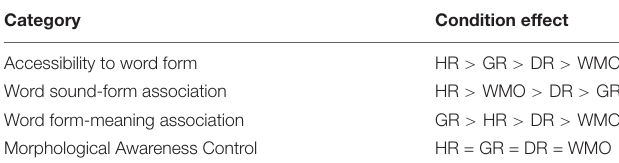
TABLE 5 | Summary of comparisons between conditions in four category